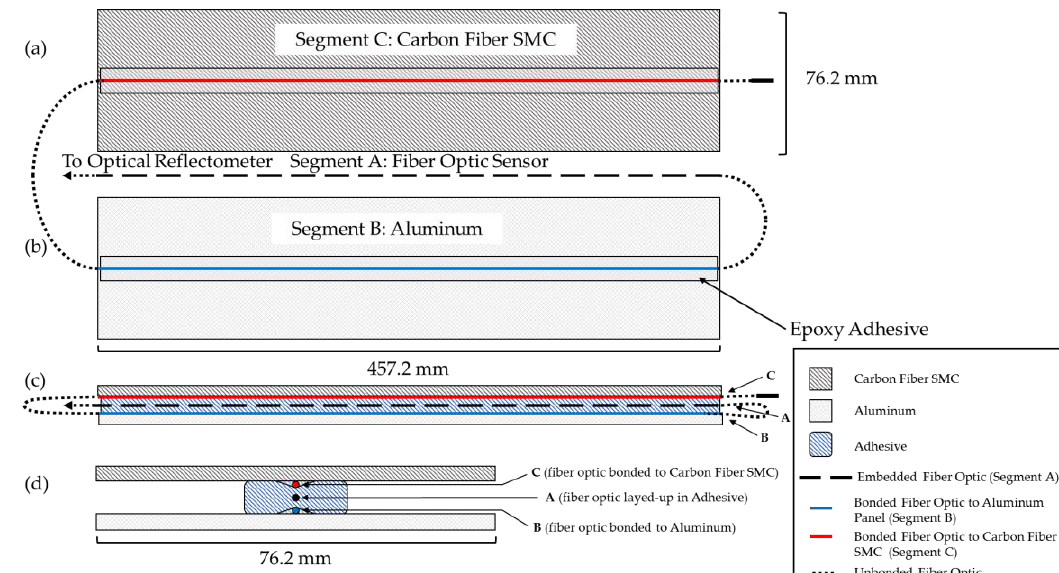
Figure 4. Schematic of ( a ) carbon fiber SMC (CFSMC) and ( b ) aluminum (Al) panel with a HD-FOS; ( c , d ) cross sections of sandwich specimens bonded to measure strain response to temperature. A carbon fiber SMC panel (Segment C) is joined to an Al panel (Segment B) with a HD-FOS (Segment A) embedded in an epoxy adhesive.